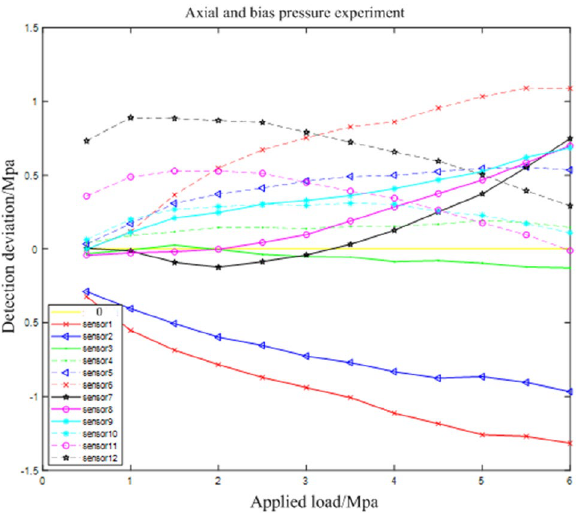
Figure 19. Correspondence graph between bias load and applied load for bias detection.